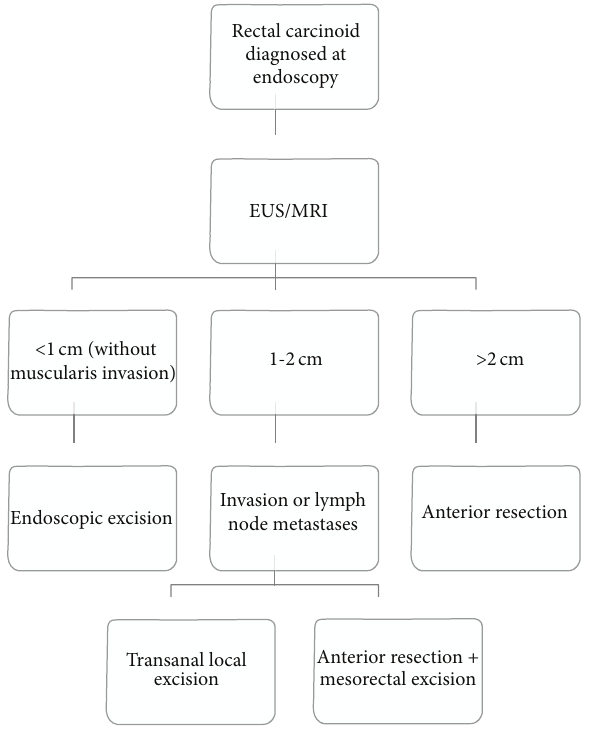
Figure 4: Management algorithm from the North American Neu- roendocrine Tumor Society (NANETS) guidelines